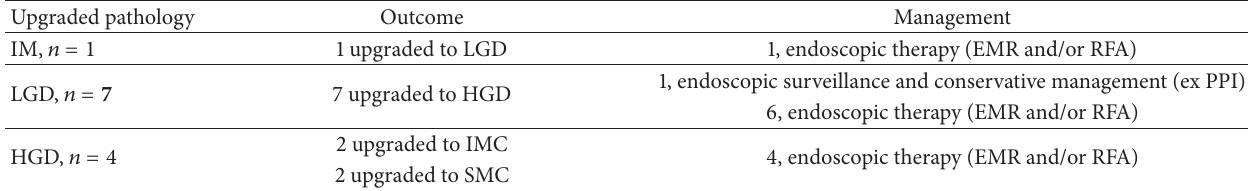
Table 4: Outcomes and management of patients with upgraded